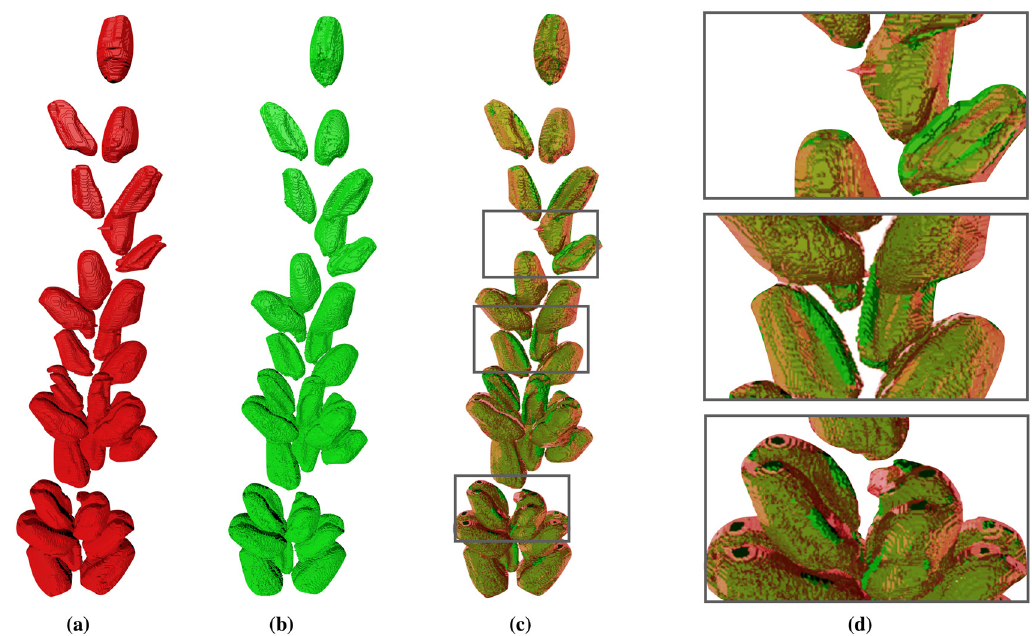
Figure 18. The details of the grain detection results for wheat spike (the bottom part of No. 1178). ( a ) Detected grains by Hughes’ method, visualized in red; ( b ) Detected grains by our method, visualized in green; ( c ) the two results are stacked together for evaluation; ( d ) Zoomed-in picture of ( c ). We can see that tips of grain (lower one) and some other voxels (middle one) are not detected using Hughes’ method, some other tissues (upper one) are erroneously detected as grains.